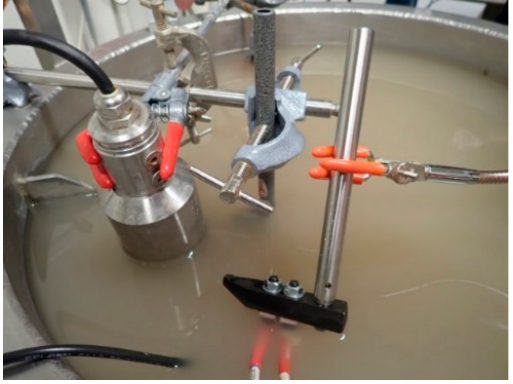
Figure 1. Picture of the experimental set-up. We used kieselguhr and kaolin as mineral substitutes of TSS. The kieselguhr particles (Celite 500, Sigma-Aldrich, St. Quentin Fallavier, France) are of various shapes with a mean diameter of 18 µm and are representative of the mineral particle fraction in rivers and wastewaters. Kaolin powder (Sigma-Aldrich), with an ovoid shape of mean diameter 5 µm, corresponds to the fine mineral particle type. Wheat starch (S5127—Starch wheat, Sigma Aldrich) is a good surrogate for the organic fraction [20]. It is of ovoid shape with a mean diameter of 18 µm as for kieselguhr particles.